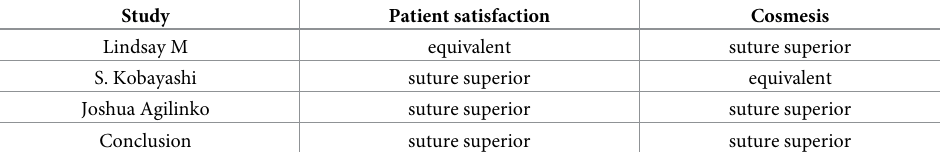
Table 3. Qualitative data of outcomes of selected studies comparing staples with subcuticular sutures in the post- operative cosmesis and patient satisfaction.